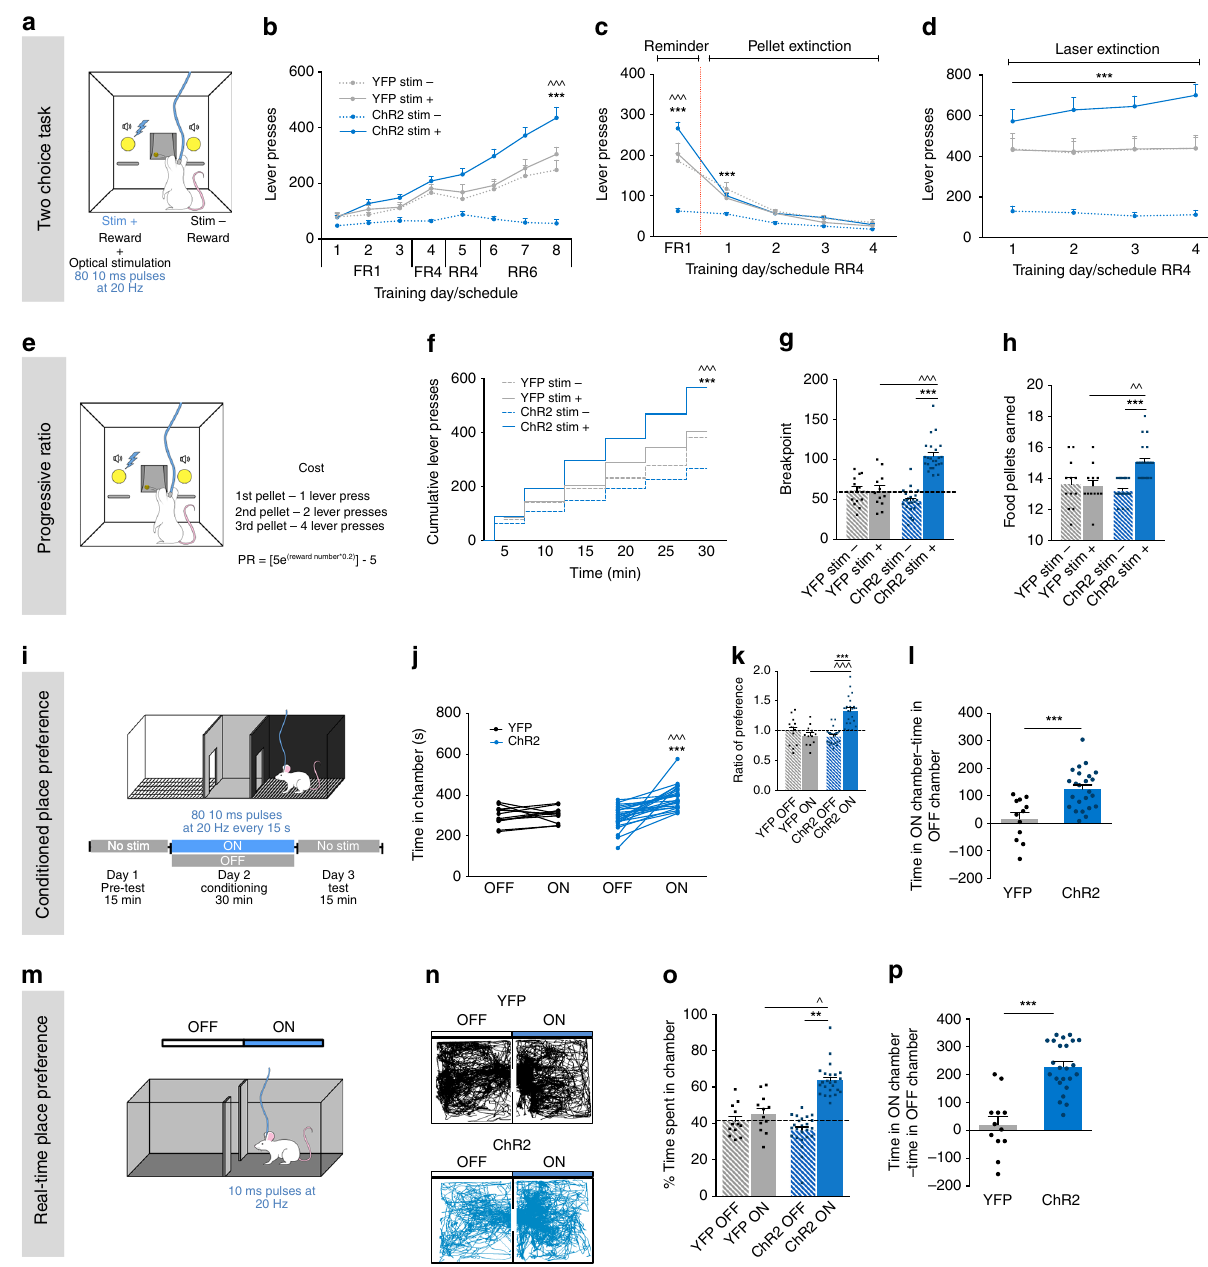
Fig. 2 LDT-NAc optical activation induces preference and increases motivation. a Schematic representation of the two-choice task. Pressing stim- lever yields one food pellet and pressing stim + lever delivers one pellet + optical stimulation of LDT-NAc inputs (80 10 ms pulses at 20 Hz). b Time-course representation of the responses in ChR2 ( n = 24) and YFP ( n = 12) rats. Optogenetic activation of LDT-NAc terminals focuses responses for the lever associated with the laser-paired reward (stim + ) over an otherwise equivalent food reward (stim-) in ChR2 animals, but not in control YFP group. c In pellet extinction conditions, both groups decrease responses for both levers. d In laser extinction conditions, ChR2 animals still manifest preference for the stim + lever, despite no stimulation being given; YFP animals do not manifest preference. e In the progressive ratio task animals have to increasingly press a lever more times to obtain the same reward (stimulation associated with stim + lever). f Cumulative presses performed during the progressive ratio task show that ChR2 animals press more on stim + lever. g Increase in breakpoint for stim + lever in ChR2 animals, indicative of enhanced motivation. h Food pellets earned during the PR task. i CPP and m RTPP paradigms, in which one chamber is associated with laser stimulation (ON side). j Total time spent in the OFF and ON sides in YFP and ChR2 groups. k Ratio of preference after CPP conditioning and l time difference, showing preference for the ON side on ChR2 but not on YFP animals. n Representative tracks for a ChR2 and a YFP animal during the RTPP. o Percentage and p difference of time spent on the ON and OFF sides, showing preference for the side associated with stimulation. Values are shown as mean ± s.e.m.*refers to difference between ChR2 stim + and stim- levers, RM 2way ANOVA; ^refers to difference between ChR2 stim + and YFP stim + levers, RM 2way ANOVA. * p < 0.05; ** p < 0.01; *** p <